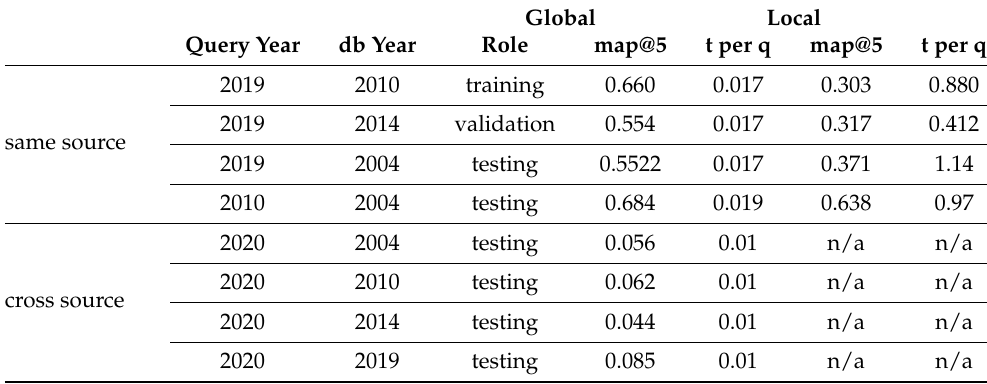
Table 6. The map@5 results for the global and local descriptors. Note that training and validation same-source training data do not contain clutter, but the testing data does. Cross-source test is performed without clutter data. Time is indicated in s.